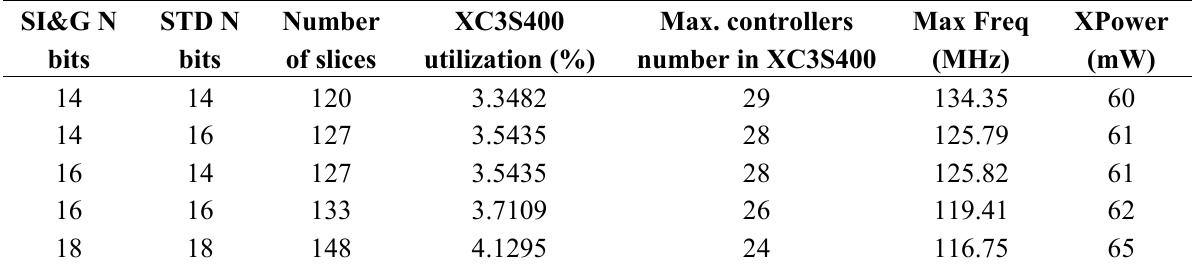
Table 2. Hardware Resources Requirements and power